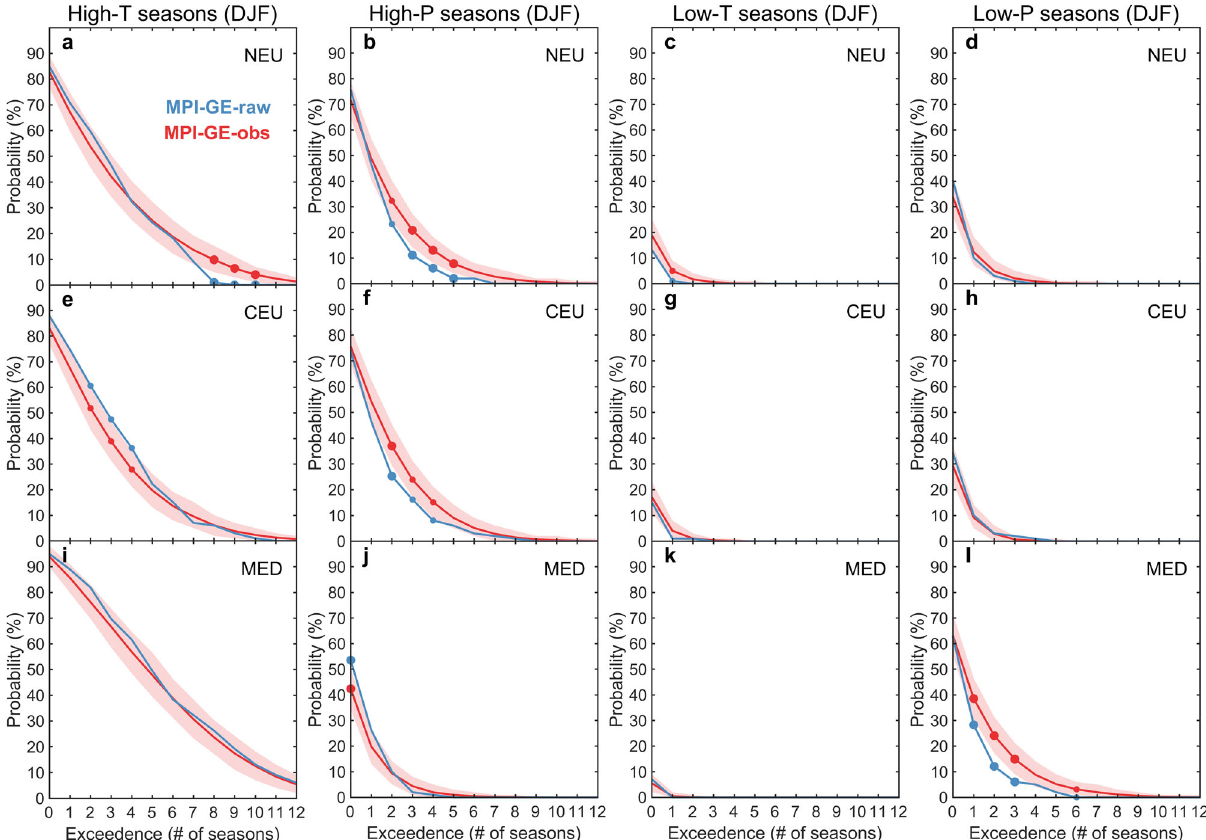
Fig. 5 Changes in the projected occurrence of extreme seasons for European winter. The probability of exceeding a number of extreme seasons over the period 2041 – 2060, where extreme seasons are de fi ned as the highest/lowest seasonal mean value over the baseline period 1995 – 2014. The panels show probability of exceeding a number of extreme seasons in the Northern Europe, Central Europe and Mediterranean regions for: a , e , i high temperatures; c , g , k low temperatures; b , f , j high precipitation; d , h , l low precipitation. Blue lines show the probability of exceeding a given number of extreme seasons in the 99-member MPI-GE-raw ensemble, while the red lines show the same for the MPI-GE-obs ensemble. The shaded regions around the MPI-GE-obs ensemble shows the 5 – 95% range of the MPI-GE-obs when only 99-members are resampled at random (10,000 times). Large dots show where the probabilities in the MPI-GE-raw and MPI-GE-obs ensembles are signi fi cantly different at the 95% level and the small dots show signi fi cance at the 90% level (based on a Monte Carlo resampling, see ‘ Methods ’ for further